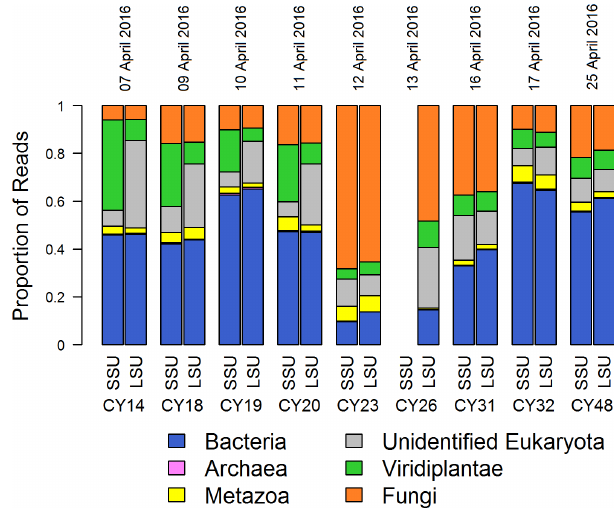
Figure 1. Taxonomic composition. Proportions of SSU and LSU reads assigned to different domains (Bacteria, Archaea, unidenti- fied Eukaryota) and kingdoms (Metazoa, Viridiplantae, Fungi) for all aerosol samples. SSU reads of CY26 were excluded because of contamination by 16S rRNA gene amplicon sequences. Eukaryota reads, which were not assigned to a kingdom or further classified, were grouped in “unidentified Eukaryota”. The proportion of Ar- chaea reads was < 1% for all